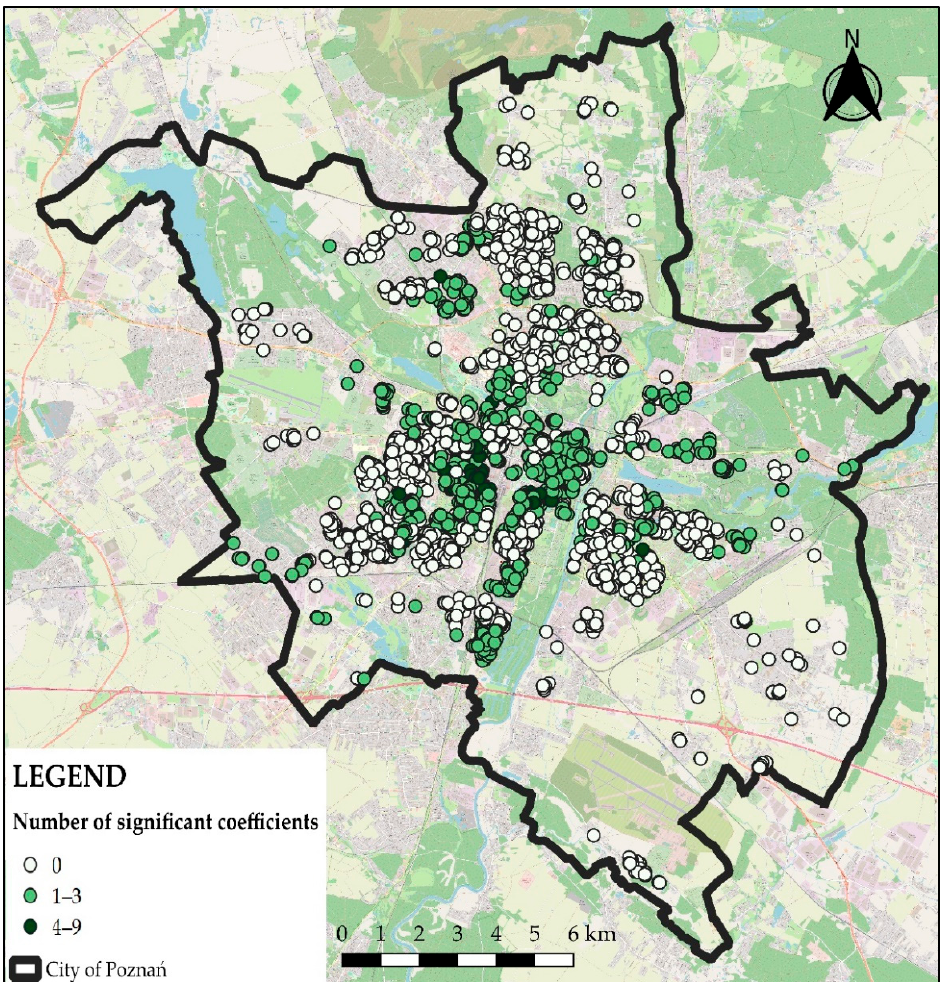
Figure 8. Number of significant coefficients for each dwelling at